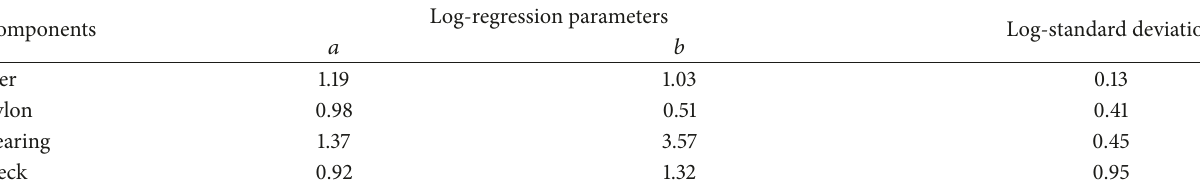
Table 4: Results from the regression